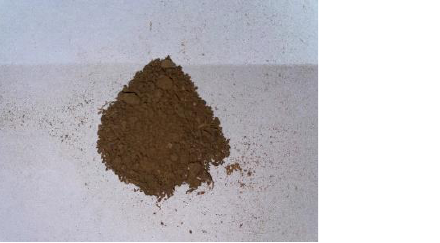
Figure 2. Macro photo of soil in Baoqizhai Village ( left ). Macro photo of soil in Dayangyu Valley ( right ).